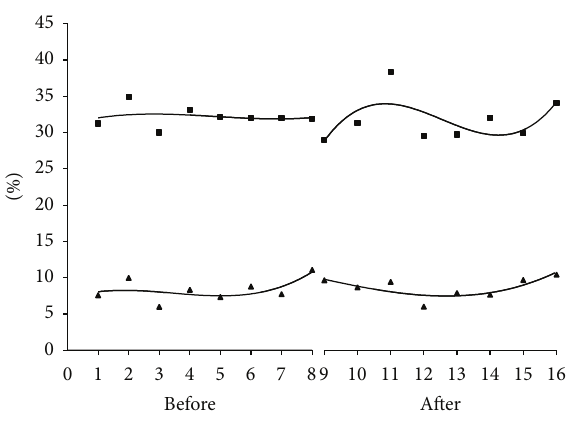
Figure 2: Percent of deliveries with a change in hemoglobin greater than 3g/dL (triangles) and greater than 2 g/dL (squares). Pre (months 1–8) and post (months 9–16). Curves are best fit third- degree